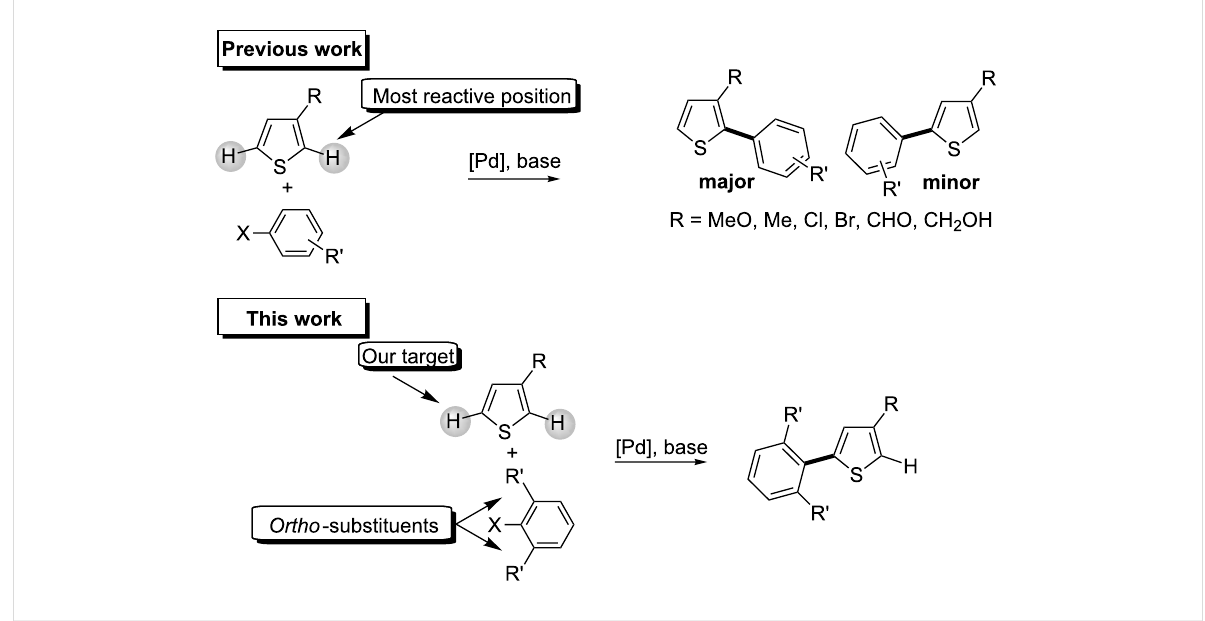
Scheme 1: Regioselectivity of coupling reactions of 3-substituted thiophenes with aryl